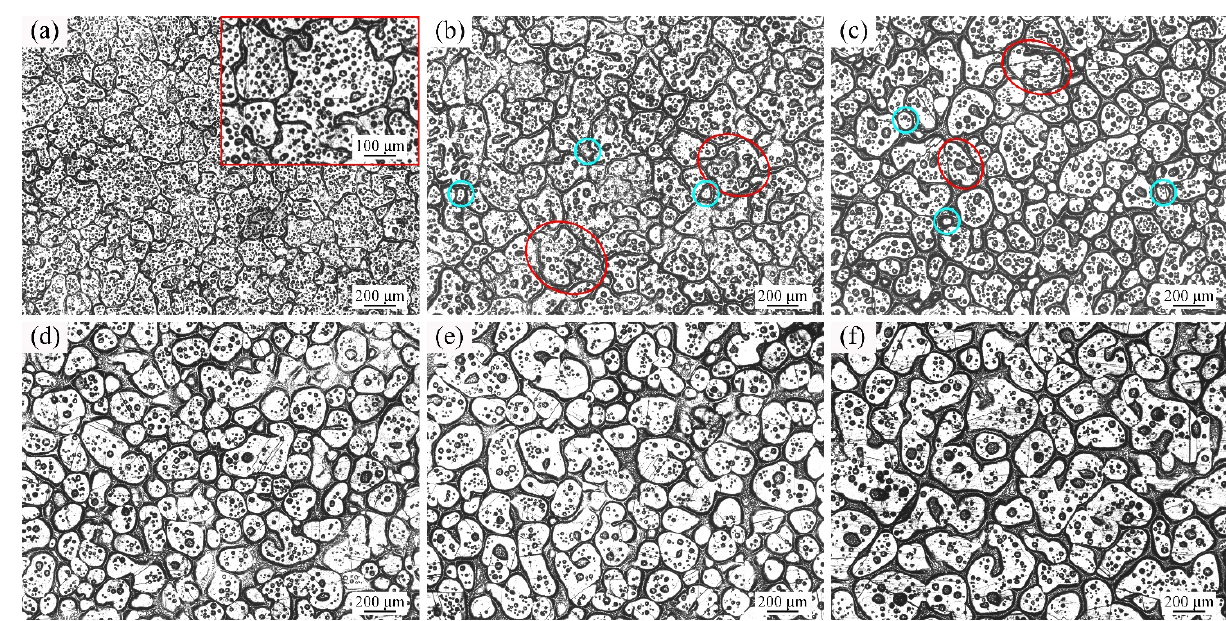
Figure 5. Optical micrographs of GH3536 alloy heat treated at 1364 °C for ( a ) 5 min, ( b ) 15 min, ( c ) 30 min, ( d ) 60 min, ( e ) 90 min, and ( f ) 120 min.